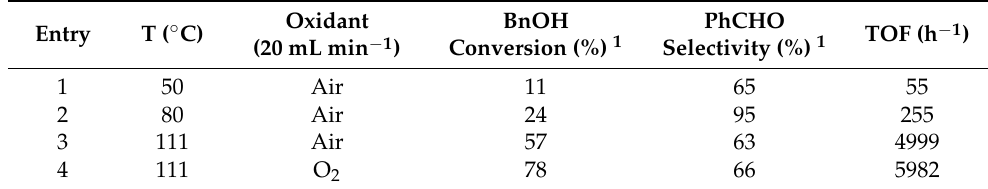
Table 6. Oxidation of BnOH in toluene over Pd-P/NH 2 -SiO 2 catalyst; effect of temperature and oxidant nature.